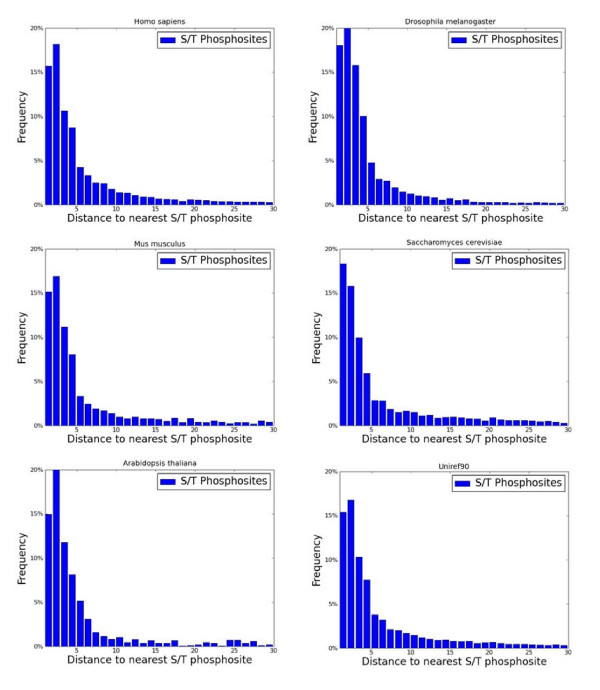
Distances of nearest phosphosites partitioned by model organisms and non redundant sequences. Analysis of ~51,000 phosphosites was performed as in Figure 2. The data were separated according to major organisms including human, mouse, Drosophila, Arabidodpsis and yeast. In all organisms, 32-37% of the pS/pT sites are within a distance smaller than 3. The data from UniRf90 show the reduction of UniProtKB phosphoproteins to a non-redundant set in which no two proteins share more than 90% sequence identity. Results from the non-redundant set (UniRef90) are identical to the complete set.